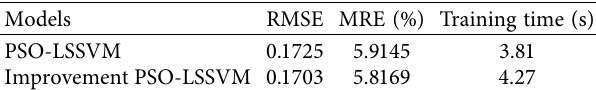
Figure 7: PSO-LSSVM adaptation function curves before and after Table 1: PSO-LSSVM network evaluation metrics before and after improvement.